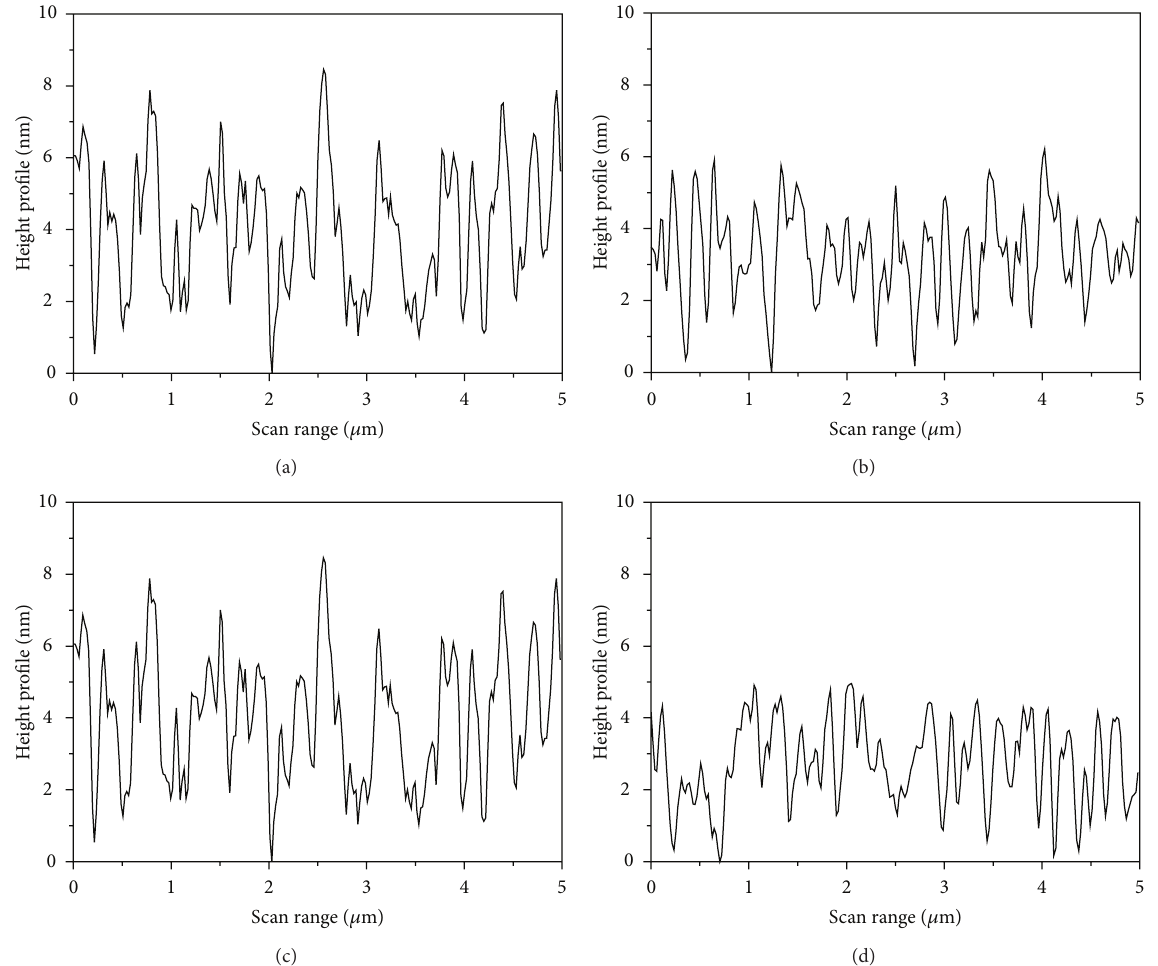
Figure 3: The height profiles of (a) bare ITO, (b) ITO/SubPc (3 nm), (c) ITO/SubPc (6nm), and (d) ITO/SubPc